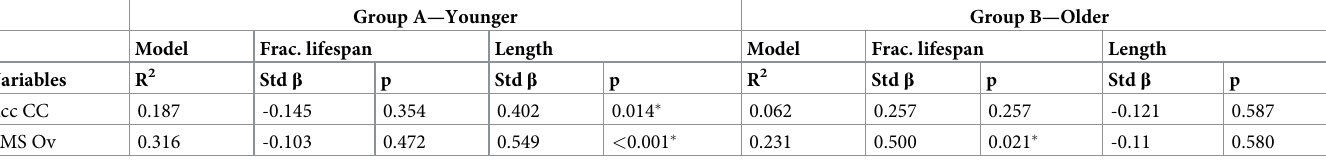
Table 5. Relationship between COP variables and FLS including length as a covariate in the